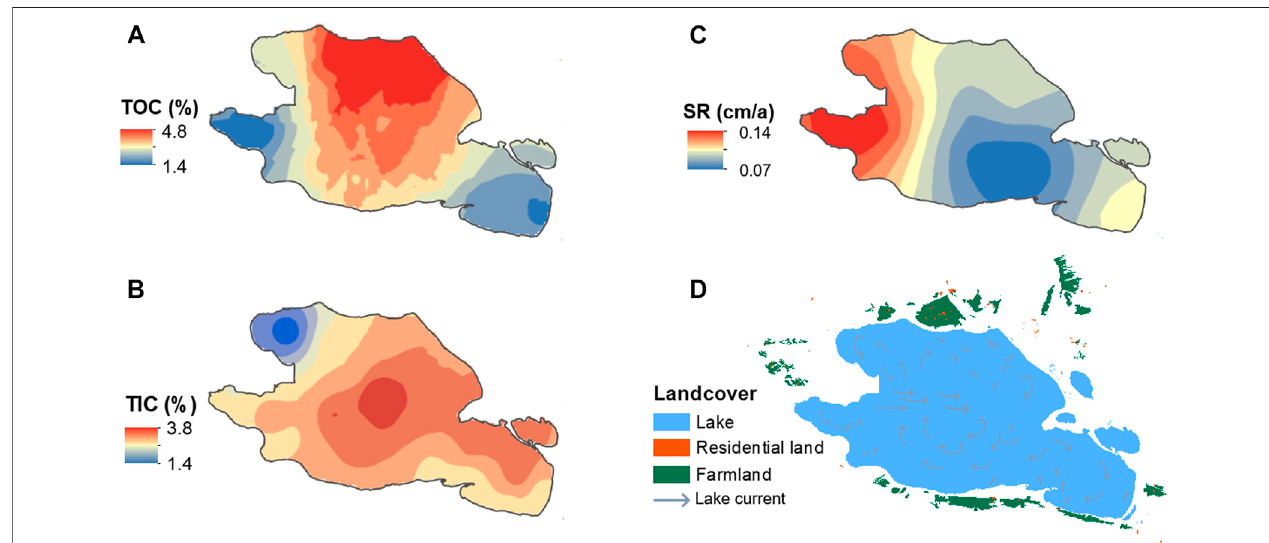
FIGURE 3 | Spatial distribution of (A) TOC, (B) TIC, (C) sediment accumulation rate (Xu et al., 2010), and (D) land use around Lake Qinghai in 2000 modi fi ed from Liu et al. (2014a) and lake current characteristics modi fi ed from Han et al. (2016).